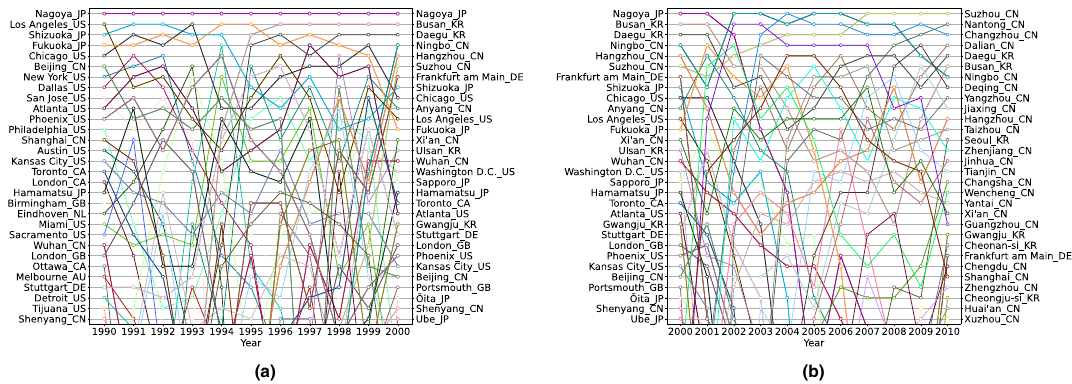
Figure 4. The Fitness rankings of metropolitan areas. The 30 MAs with the highest Fitness are shown, along with the evolution from 1990 to 2000 (a) and from 2000 to 2010 (b) . In 1990 many of the metropolitan areas in the top 30 of the Fitness rankings were from the US, Europe, Canada and Japan, with only Shanghai and Beijing from China in the first 20. In 2000, Chinese and Korean MAs appear in the top 30, and in 2010 they dominate the top of the Fitness rankings with Frankfurt as the only European, 6 Korean MAs and all others being